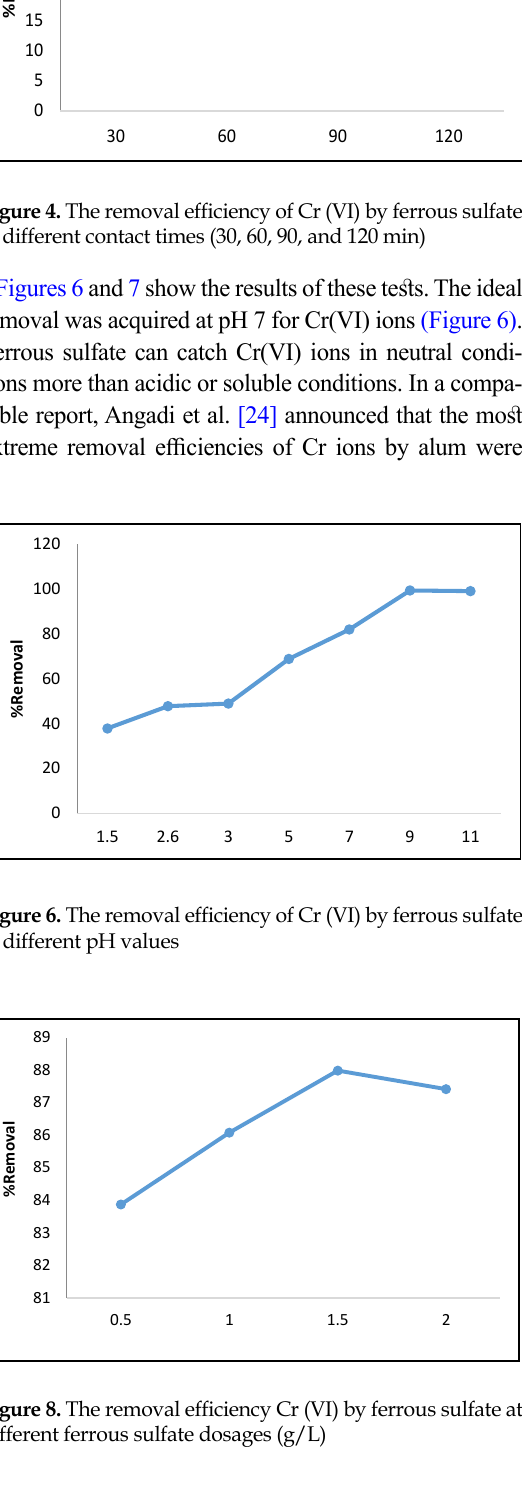
different ferrous sulfate dosages (g/ L )